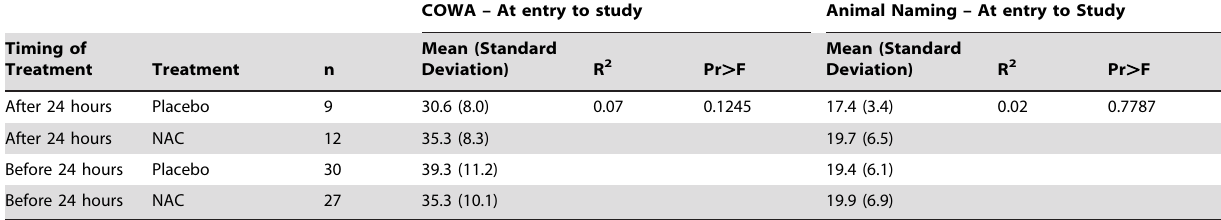
COWA – At entry to study Animal Naming – At entry to